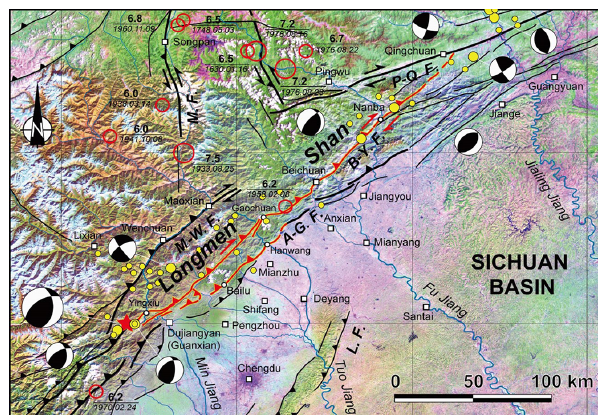
Figure 10. Recent large earthquakes along the eastern margin of the Tibetan Plateau. Red lines show two surface rupture zones caused by the M w 7.9 Wenchuan earthquake.